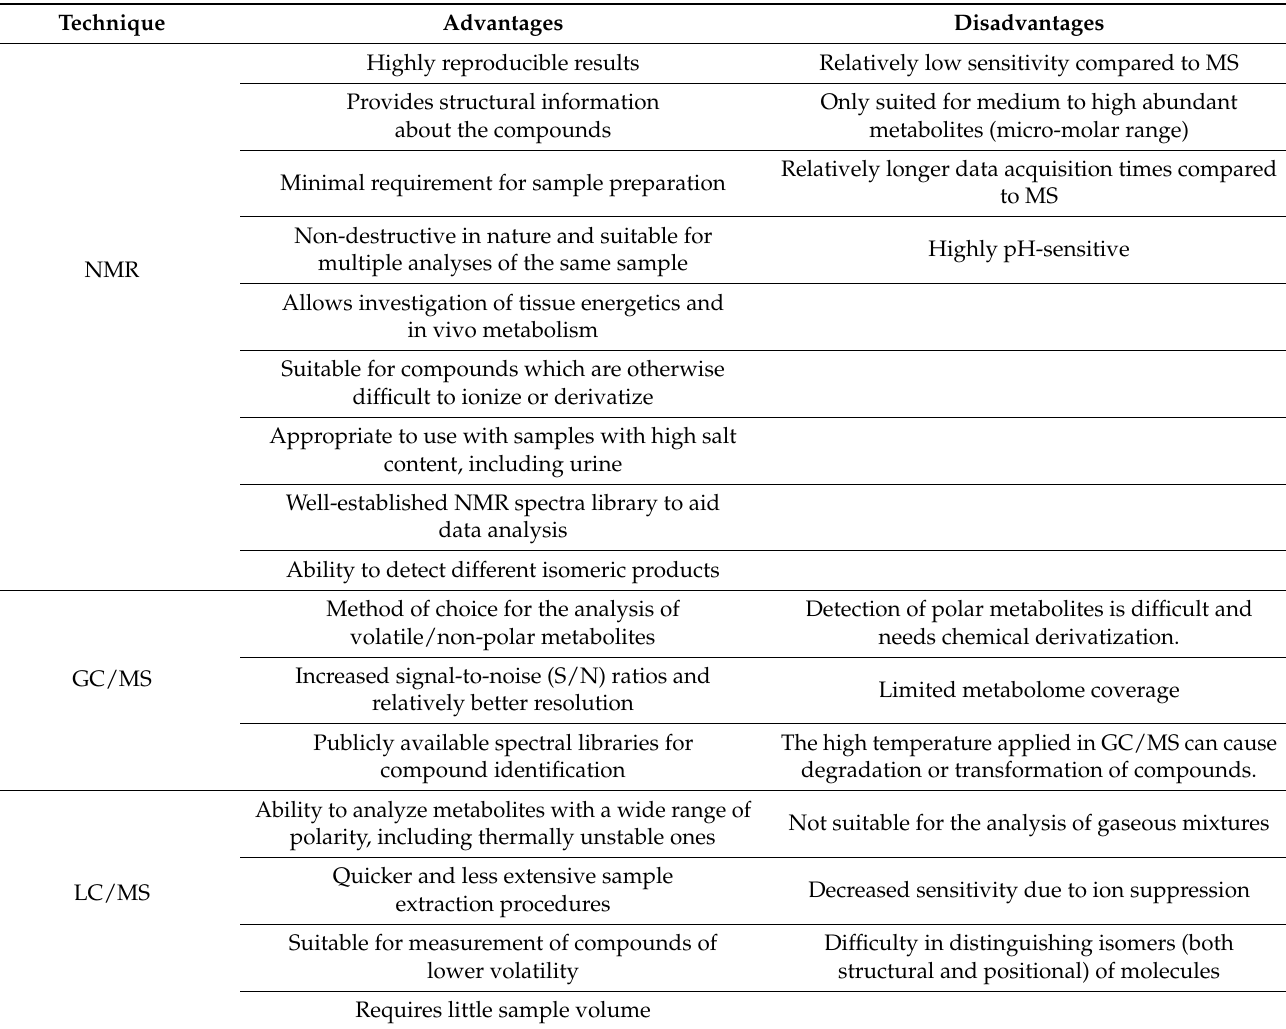
Table 1. A summary of the important advantages and limitations of NMR and MS techniques.